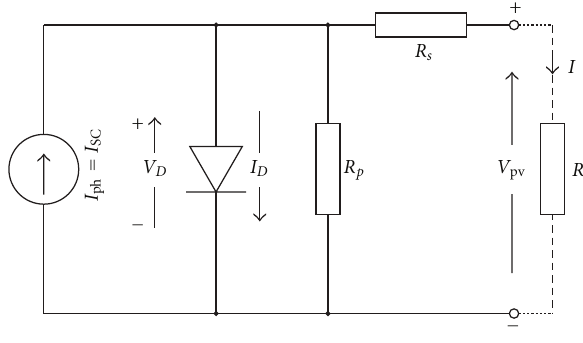
Figure 1: Equivalent electrical circuit of an SC.